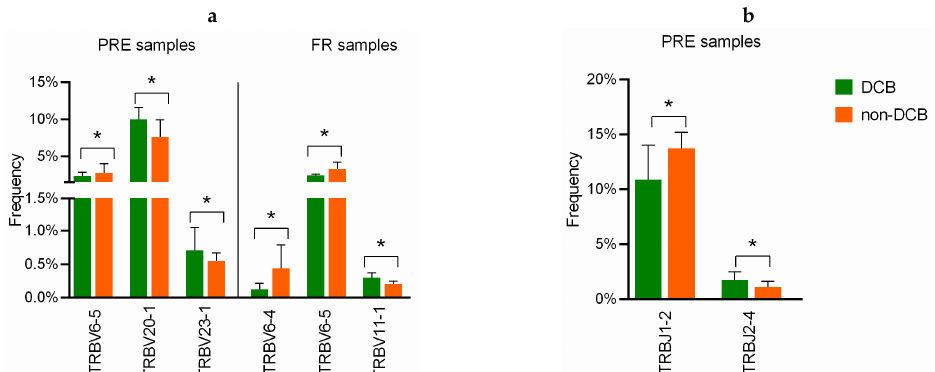
Figure 7. Comparison of V and J-gene usage between anti-PD-1 treated NSCLC patients with DCB vs. non-DCB. ( a ) V-gene usage in pretreatment (PRE) and first response assessment (FR) samples. ( b ) J-gene usage in PRE samples. Statistical analysis was performed using the Mann–Whitney test. The height of each column represents the median of the frequency and the error bars depict the interquartile range. DCB: durable clinical benefit, in green; non-DCB: non-durable clinical benefit, in orange. * p < 0.05. Cancers 2021 , 13 , x